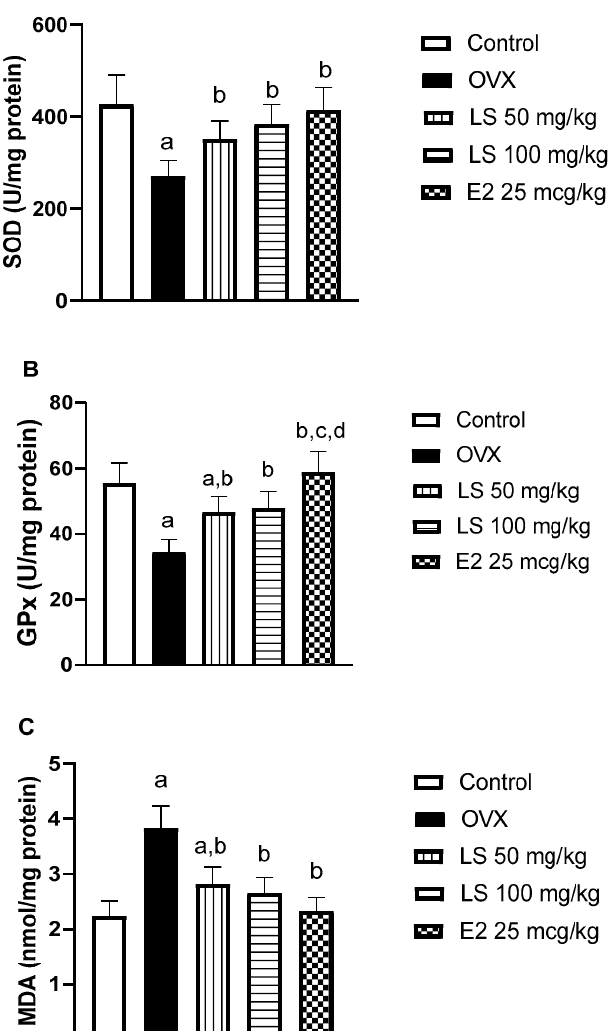
Figure 3. E ff ect of L. sativum (LS) on superoxide dismutase (SOD) activity ( A ), glutathione peroxidase (GPx) activity ( B ) and malondialdehyde (MDA) content ( C ) in femur tissues of ovariectomized rats. Data are presented as M ± SD. (a) Significantly di ff erent from control at p < 0.05. (b) Significantly di ff erent from OVX at p < 0.05. (c) Significantly di ff erent from LS 50 mg / kg at p < 0.05. (d) Significantly di ff erent from LS 100 mg / kg at p < 0.05.